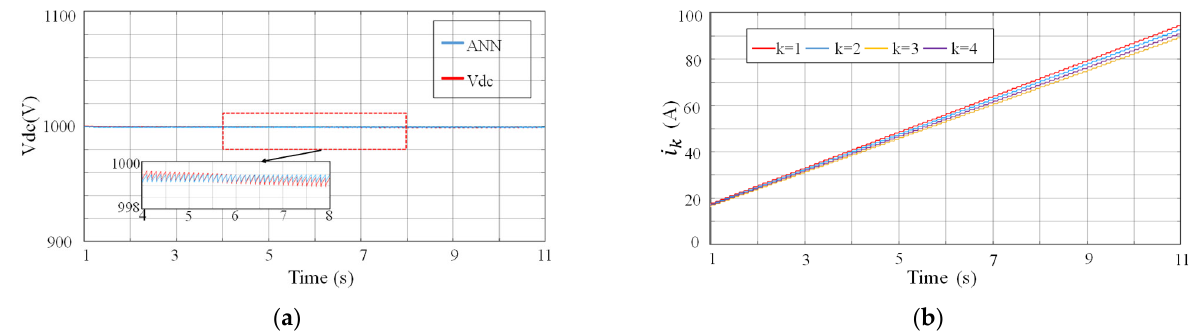
Figure 5. ( a ) Values of DC bus voltage and ANN output in case study 1; ( b ) Values of currents of the bidirectional DC ‐ DC converters in case study 1.